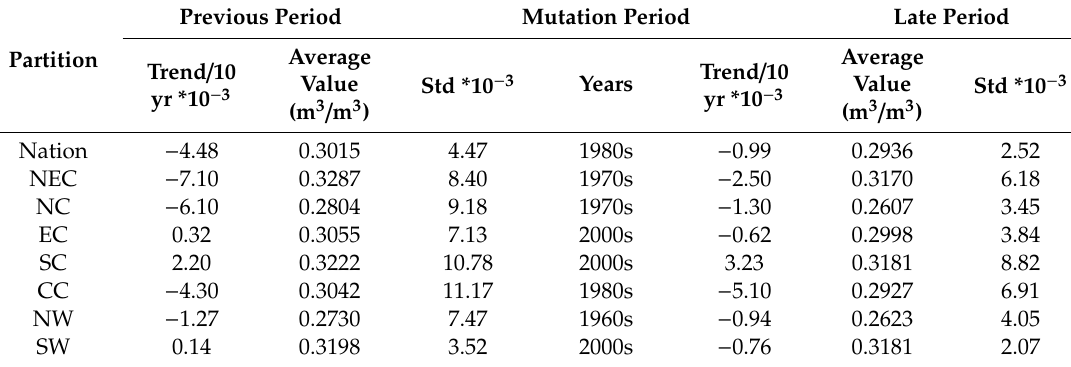
Table 2. Soil moisture variation trends and mutation